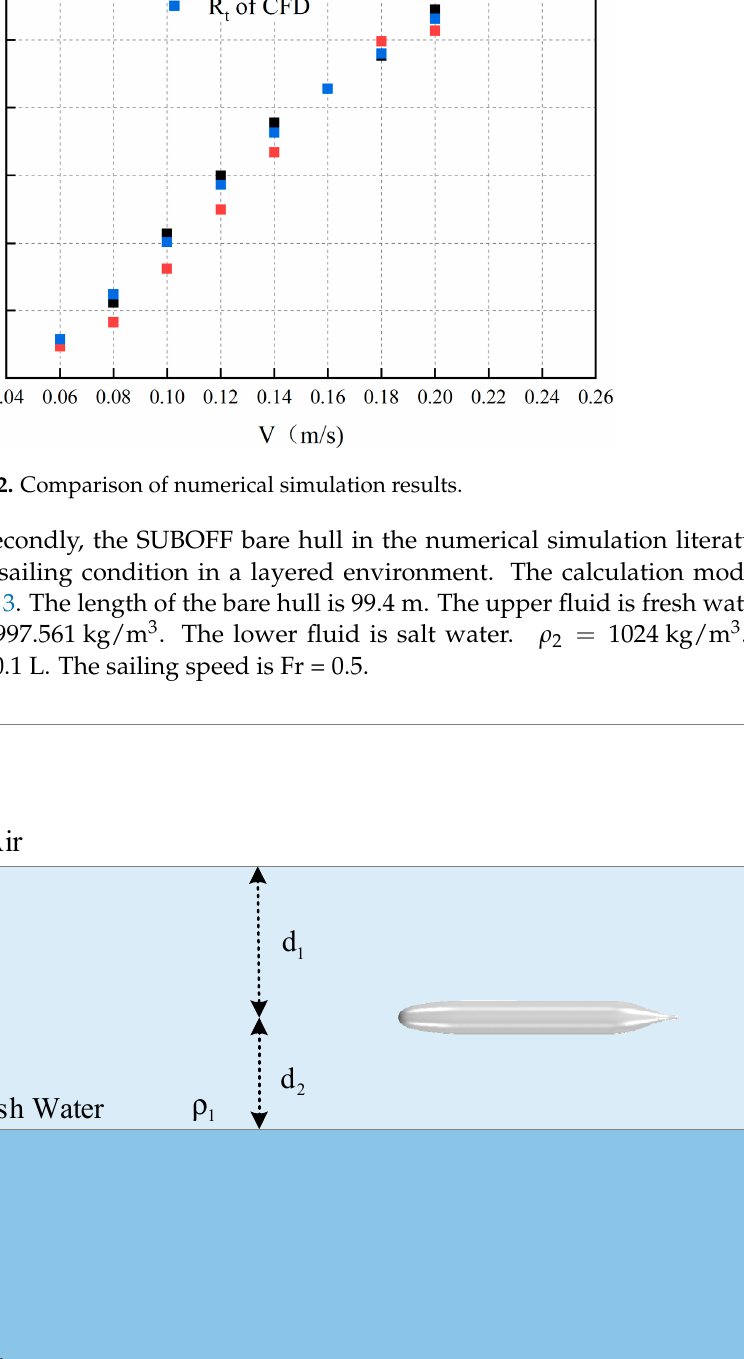
Figure 4. Longitudinal section wave cut diagram of direct flight.